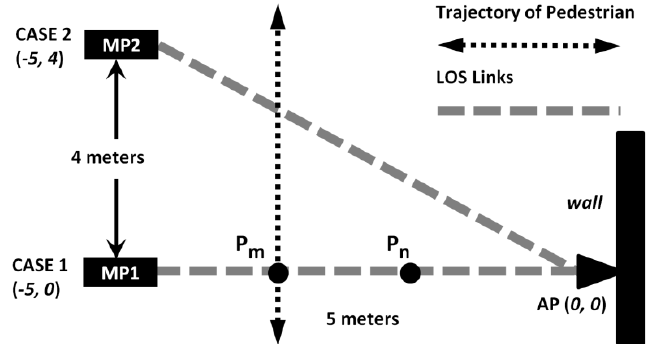
Figure 1. Two monitoring point (MP) locations to investigate temporal characteristic of Radio Frequency (RF) Tomography: Case 1: the MP is located at (−5, 0); Case 2: the MP is located at (−5, 4).